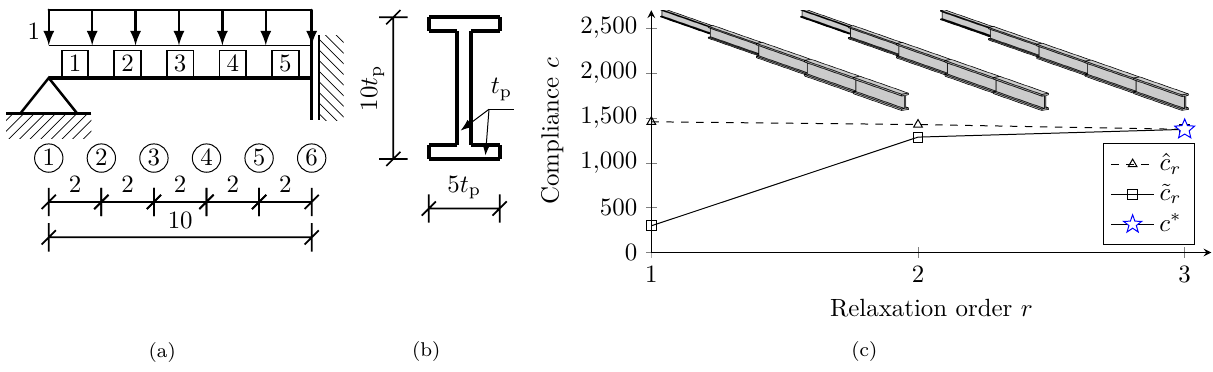
Figure 3. Girder beam design problem. (a) shows the design domain, (b) the cross-sectional shape, and (c) the convergence of polynomial optimization.